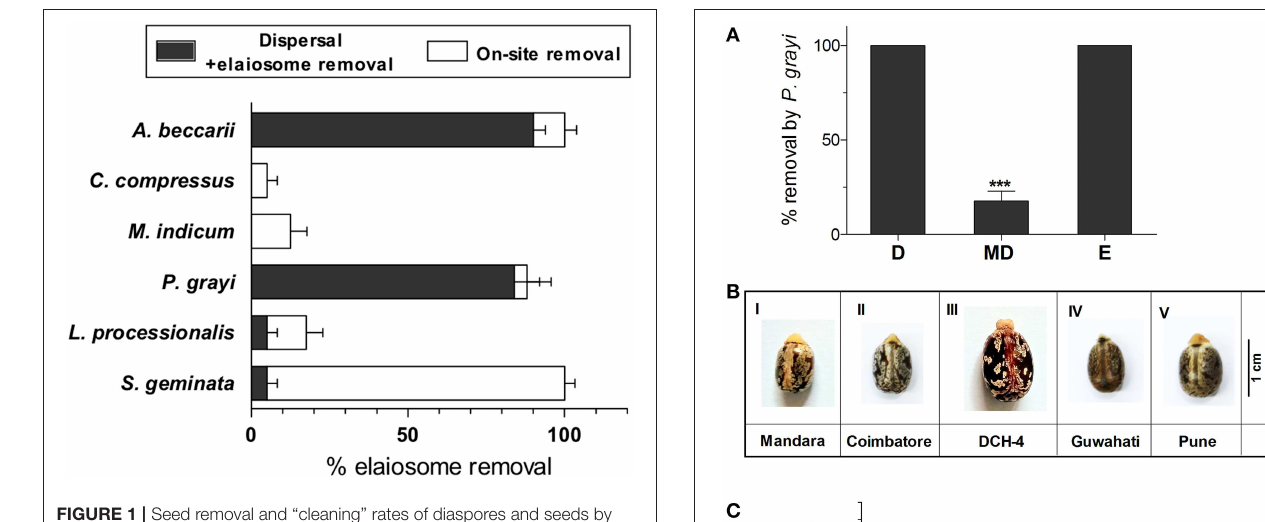
FIGURE 1 | Seed removal and “cleaning” rates of diaspores and seeds by ants of Mandara. Data represents mean ± SE (E, elaiosomes) ( n = 8).